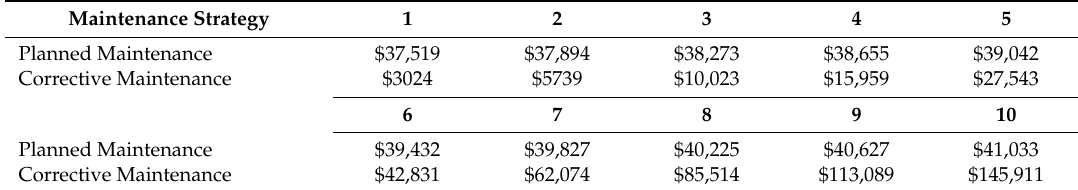
Table 13. Estimated person-hour costs to both types of interventions (year 1 to year